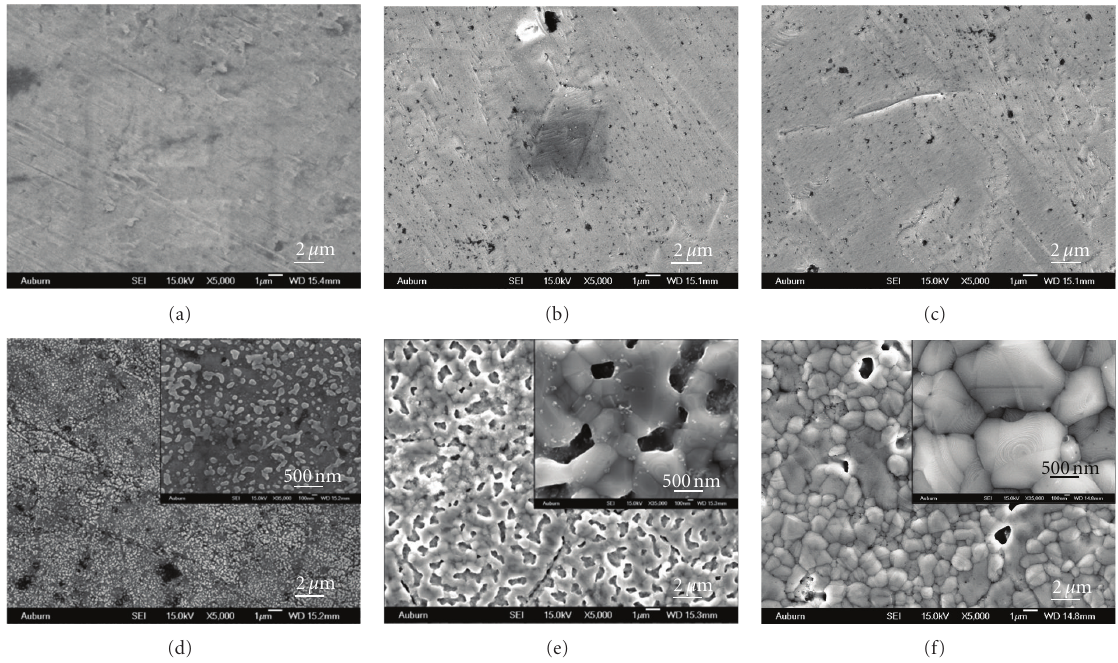
Figure 4: E ff ects of pretreatment on nickel foil: (a) as-received, (b) reduced at 715 ◦ C for 15min, (c) reduced at 815 ◦ C for 120 min, (d) thermal faceting at 515 ◦ C, (e) thermal faceting at 715 ◦ C, and (f) thermal faceting at 815 ◦ C (Table 1 (Phase 1)).